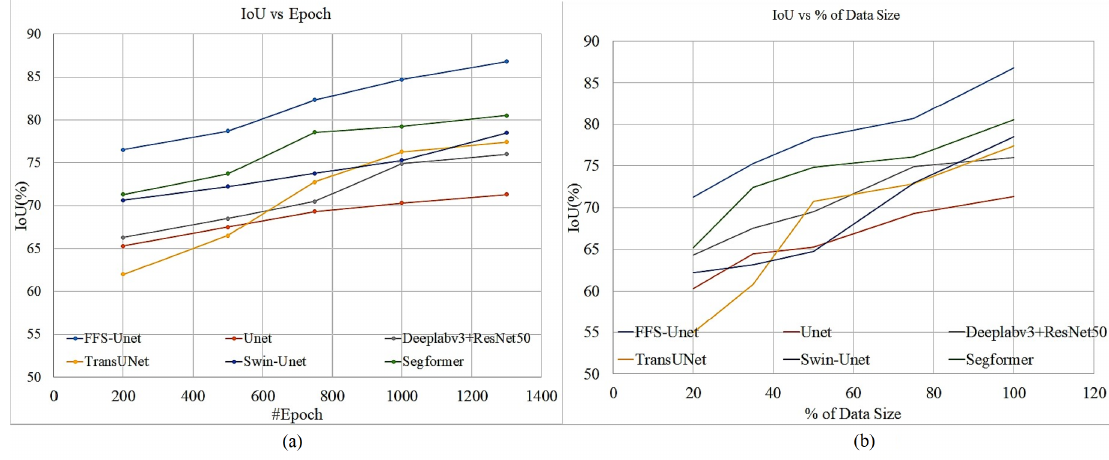
Figure 13. Comparison ( a ) training effect and ( b ) data size effect of different